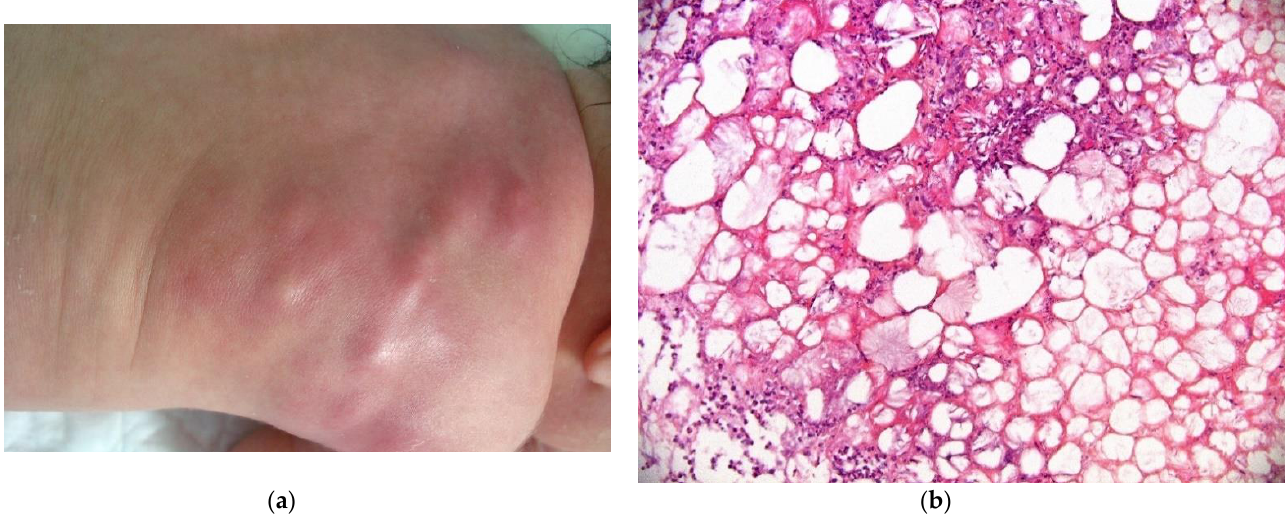
Figure 11. Subcutaneous fat necrosis of the newborn. ( a ) Multiple skin-colored nodular lesions at the upper back. ( b ) 10× lobular panniculitis with inflammatory cells and typical radially arranged needle-shaped cleft into the fatty tissue.